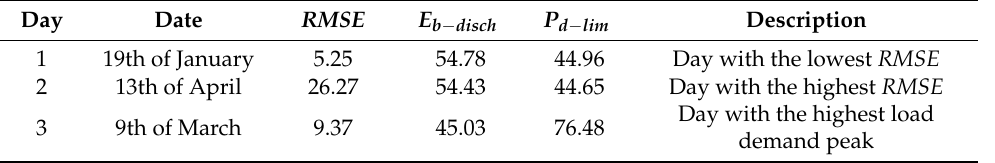
Table 8. RMSE , E b-disch , and P d-lim for the three days using predicted data.